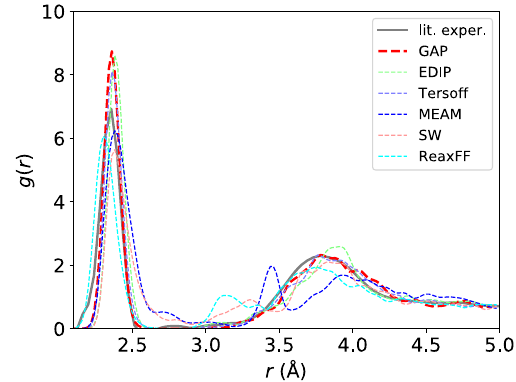
FIG. 9. RDF for a 216-atom amorphous configuration gener- ated by cooling at 10 12 K = s from 2000 to 500 K and then minimized, for GAP (red) and other interatomic potentials (other colors). Experimental results (gray) generated by ion implanta- tion from Ref. [186] are shown for